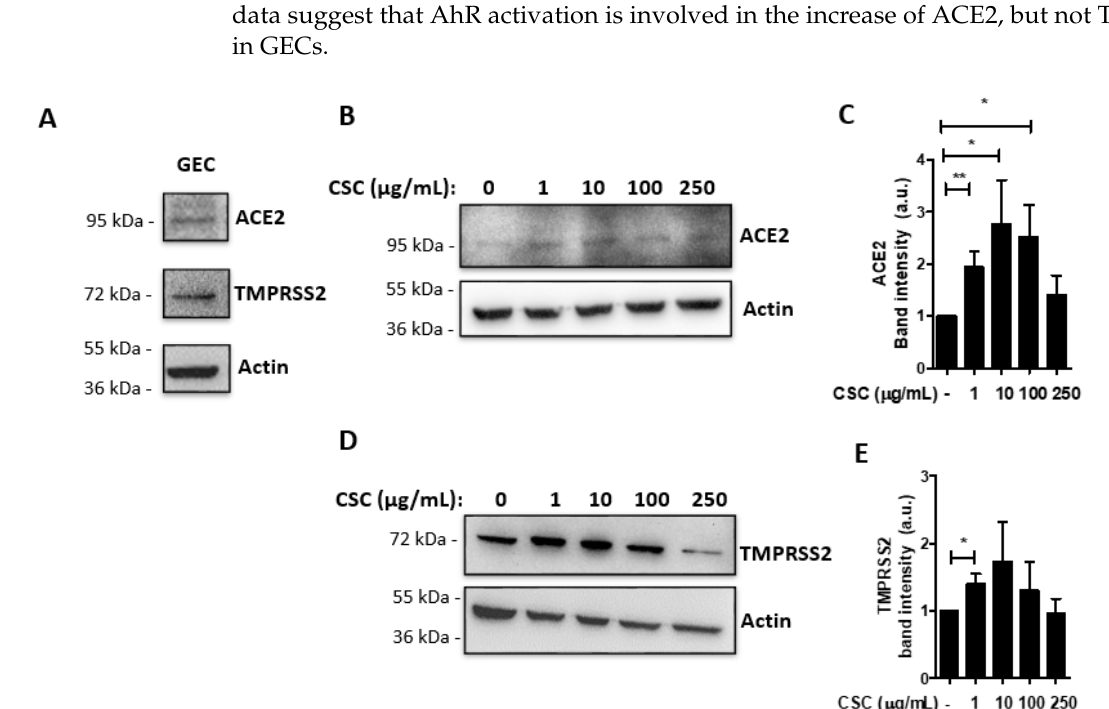
Figure 1. Cigarette smoke condensate treatment increases angiotensin-converting enzyme 2 (ACE2) and transmembrane serine protease 2 (TMPRSS2) levels in human gingival epithelial cells. Human gingival epithelial cells (GECs) were treated with or without cigarette smoke condensates (CSC) at different concentrations for 24 h, and expression of ACE2 and TMPRSS2 were determined by Western blot. ( A ) shows a representative Western blot image for ACE2 and TMPRSS2 in untreated GECs. ( B ) shows representative Western blot images for ACE2 and ( D ) TMPRSS2 after treatment with CSC at different concentrations for 24 h. ( C , E ) Graphs show average ± SEM of band intensity (arbitrary units) for ACE2 ( C ) and TMPRSS2 ( E ) . ( A ) n = 3, ( B , C ) n = 7, ( D , E ) n = 6. * p ≤ 0.05; ** p ≤ 0.01.